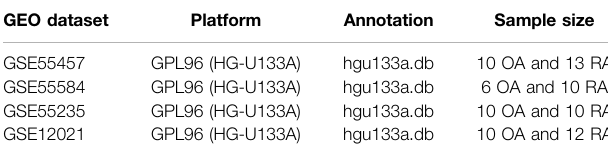
TABLE 1 | The detailed information of the Gene Expression Omnibus (GEO)